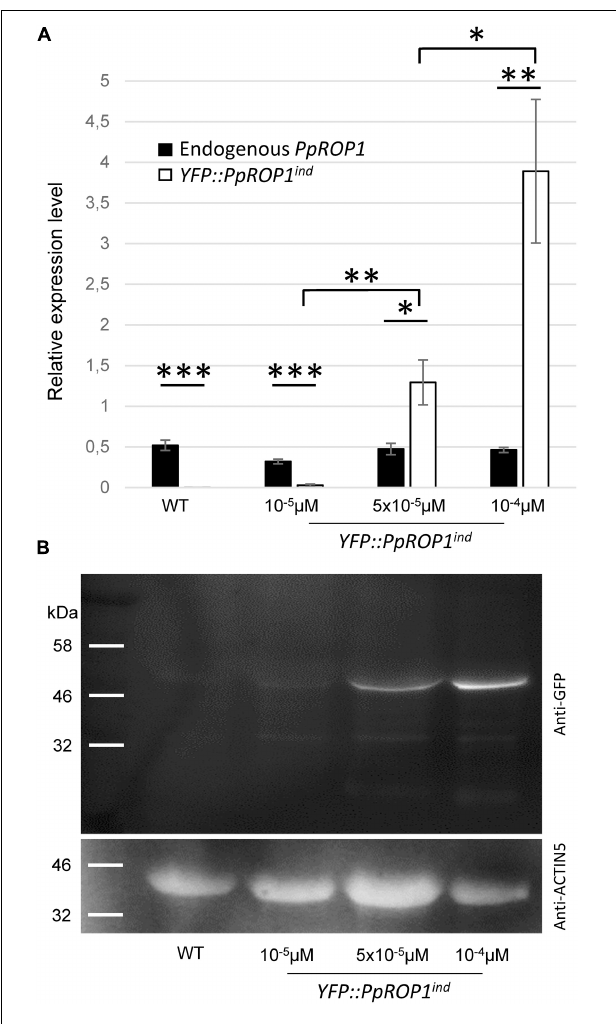
FIGURE 9 | PpROP1 and YFP::PpROP1 transcript levels, as well as YFP::PpROP1 protein levels, in YFP::PpROP1 ind protonemata induced with 10 − 5 µ M, 5 × 10 − 5 µ M, or 10 − 4 µ M estradiol. (A) Endogenous PpROP1 and inducible YFP::PpROP1 expression levels as determined by qPCR in WT protonemata and in YFP::PpROP1 ind protonemata grown in the presence of estradiol at the indicated concentrations. Relative expression levels are indicated, which represent absolute PpROP1 and YFP::PpROP1 transcript levels normalized relative to the absolute transcript level of the reference gene UbC-E2 . The statistical significance of differences between all data sets was assessed using ANOVA (Bonferroni-Holm, one factor). ∗ P < 0.05; ∗∗ P < 0.01; ∗∗∗ P < 0.001: statistically significant differences relevant in the context of this study. Error bars: standard deviation. (B) Total proteins extracted from WT protonemata and from YFP::PpROP1 ind protonemata grown in the presence of estradiol at the indicated concentrations were separated by SDS-PAGE and analyzed by immunoblotting using either an anti-GFP (upper panel) or an anti-actin (lower panel) antibody (chemiluminescence detection). Immunoblotting using the anti-actin antibody served as loading control. Predicted sizes of YFP::PpROP1 and PpACTIN5 are 50 and 42 kDa, respectively.